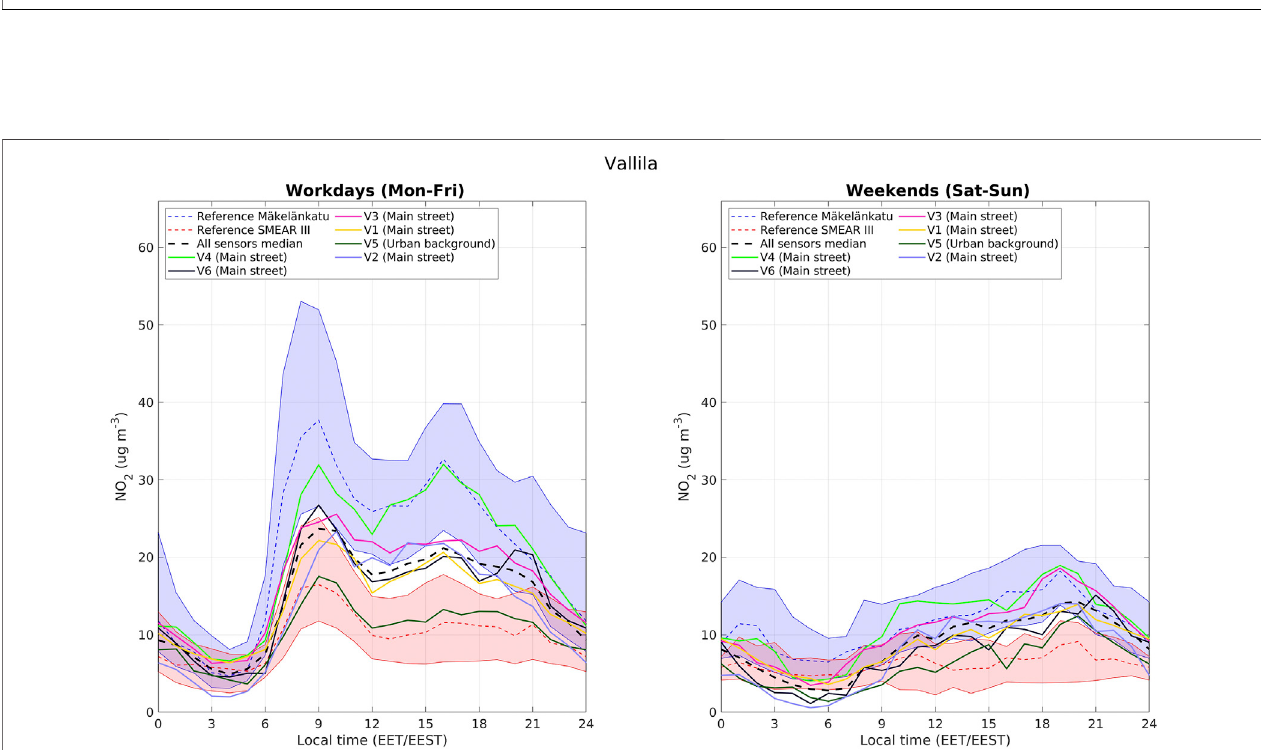
FIGURE 6| Median diurnal cycle of NO2during 5-month period (1.8.-31.12.2020) for sensors located in Vallila (left) workdays (Mon-Fri) and (right) weekends (Sat- Sun). Reference measurements show median (dashed line) and 25th and 75th percentiles (shaded area) from nearest reference instruments. Black dashed line shows median diurnal cycle calculated for all data from that location.